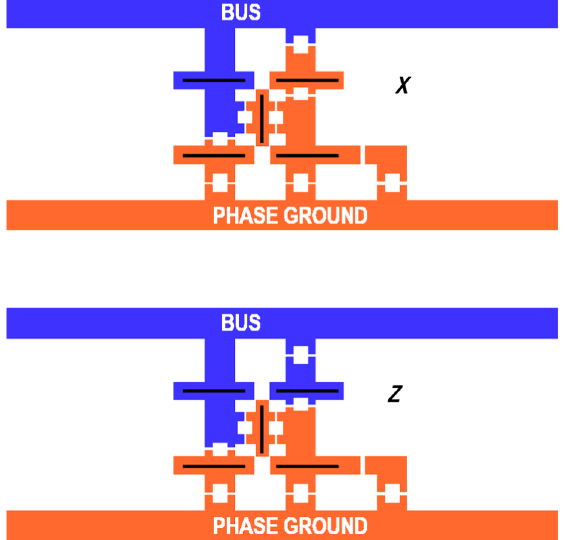
FIG. 11. Measurement of the X and Z projections of the upper qubit. The parity of a set of MZMs is measured by Josephson coupling the corresponding superconducting islands strongly to the bus while coupling the remaining islands to the phase ground.